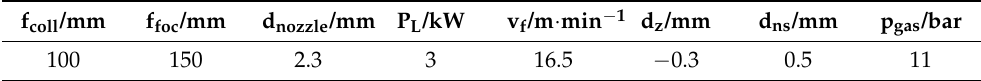
Table 2. Process parameters for laser